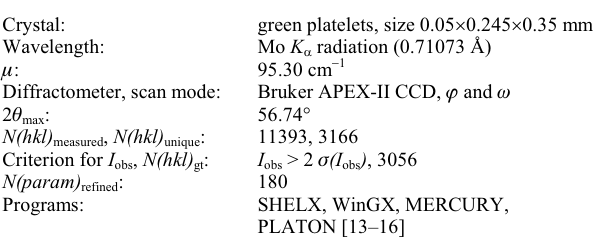
Table 1. Data collection and